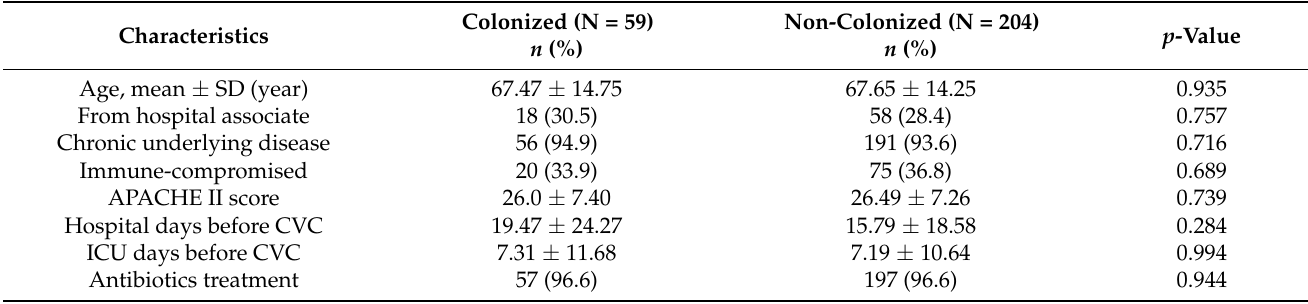
Table 4. Factors associated with flora colonization at the CVC insertion